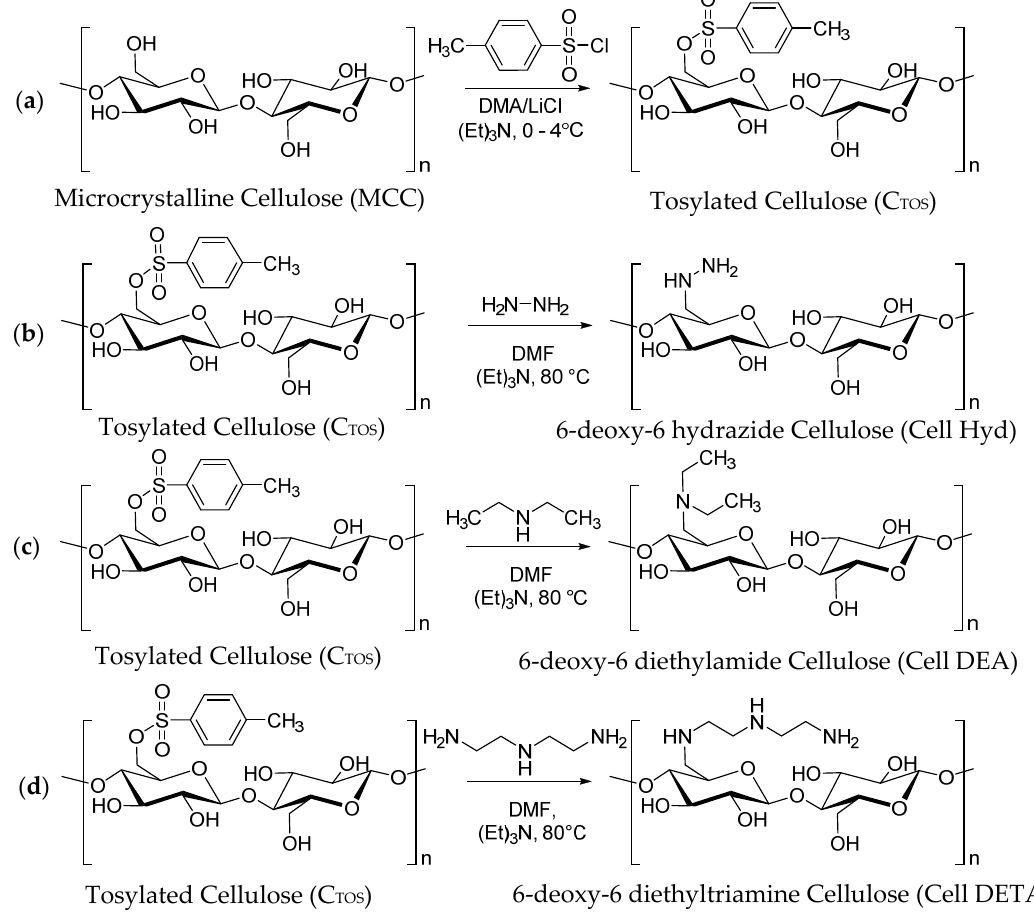
Figure 2. Scheme of Synthesis of Microcrystalline Cellulose (MCC) Derivatives: ( a ) Tosylated cellulose (CTos) synthesis, ( b ) synthesis of 6-deoxy-6-hydrazide Cellulose (Cell Hyd), ( c ) synthesis of 6-deoxy-6-diethylamide Cellulose (Cell DEA), ( d ) synthesis of 6-deoxy-6-diethyltriamine Cellulose (Cell DETA).